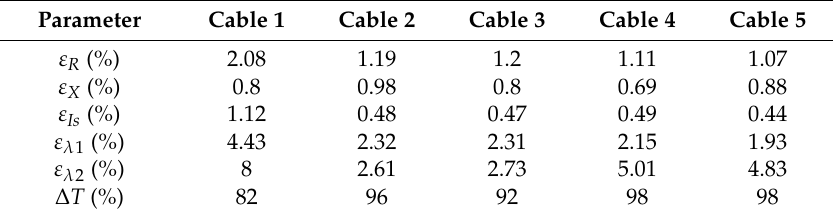
Table 2. Error in R , X , I s , λ 1 , λ 2 and simulation time reduction in relation to full periodic models for L = 1.25 CP .